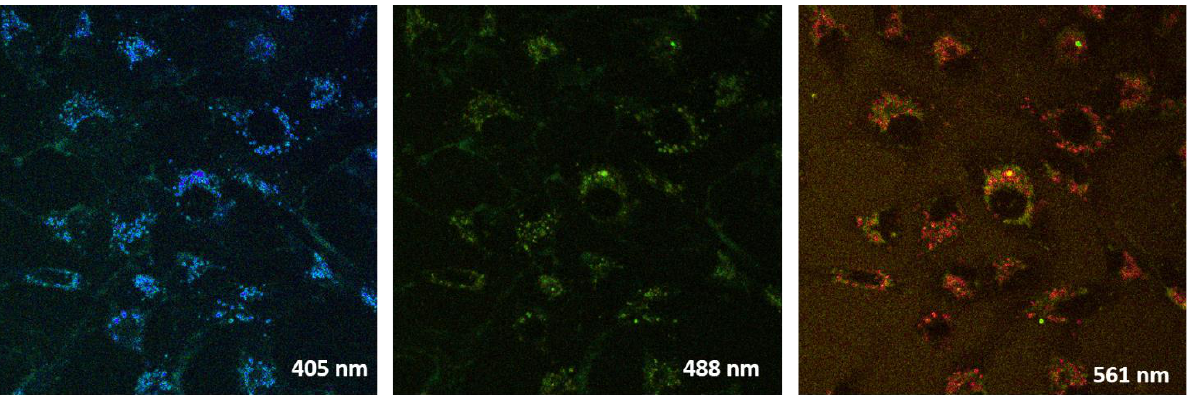
Figure 4. Images of Vero cells stained with compound 6a excited by lasers with different wavelengths.